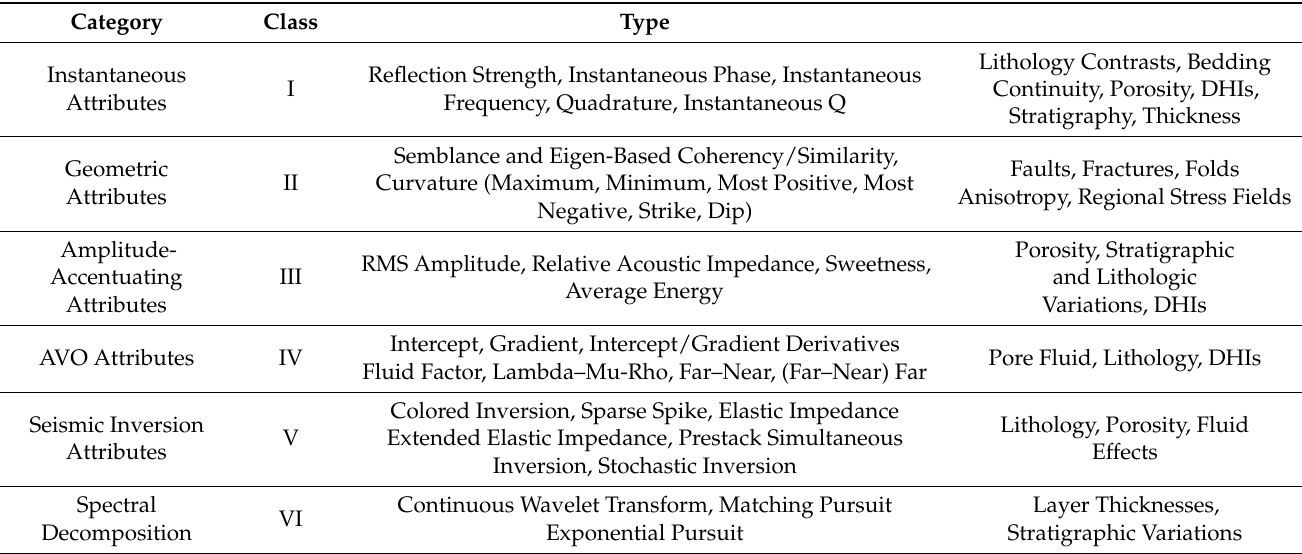
Table 1. Seismic attribute classification used as guided by